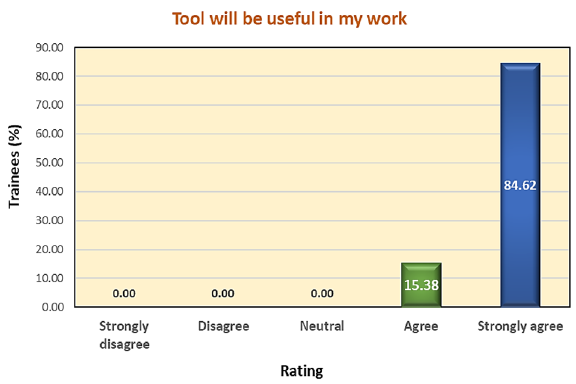
Figure 6. Response by users regarding the utility of the tool.